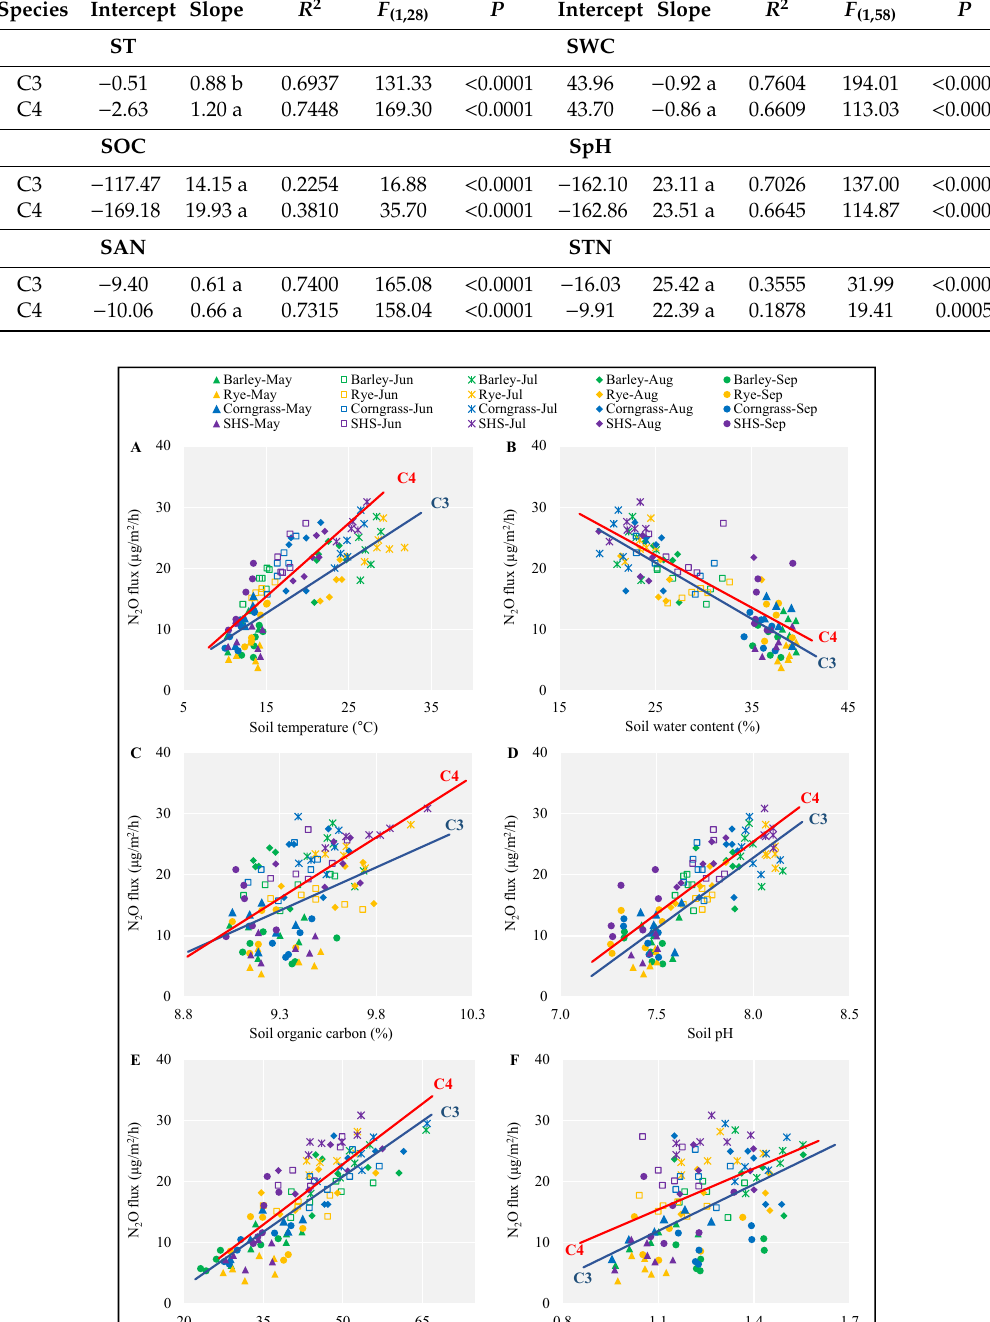
Figure 4. The linear regressions between soil N 2 O fluxes and soil properties of soil temperature ( A ), soil water content ( B ), soil organic carbon ( C ), soil pH ( D ), soil available nitrogen ( E ), and soil total nitrogen ( F ) in barley, rye, corngrass, and SHS fields. The statistical results are summarized in Table 2 for each species and in Table 3 for C3 and C4 species. Table 2. Summary of linear regressions (Figure 3) between soil N 2 O fluxes and soil properties: soil temperature (ST), soil water content (SWC), soil organic carbon (SOC), soil pH (SpH), soil available nitrogen (SAT), and soil total nitrogen (STN) in barley, rye, corngrass, and SHS fields. For each soil property, slopes with the same letters are not significantly different between species ( P > 0.05).